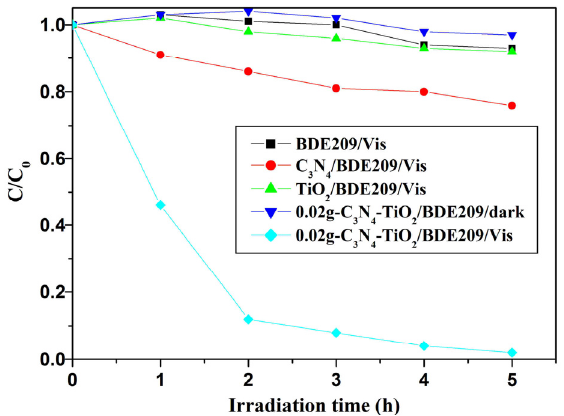
Figure 4. Temporal curves of the degradation of BDE209 under different conditions. BDE209: 1.0 × 10 − 5 mol/L; 0.02 ‐ g ‐ C 3 N 4 ‐ TiO 2 : 1 mg/mL; solvent: CH 3 OH; wavelength >420 nm; anoxic condition. 1.0 × 10 − 5 mol/L; 0.02-g-C 3 N 4 -TiO 2 : 1 mg/mL; solvent: CH 3 OH; wavelength >420 nm; anoxic